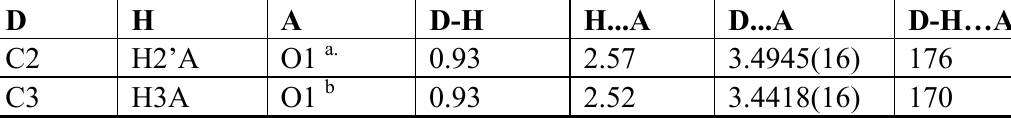
Table 6. Hydrogen bonding data for compound 16 .